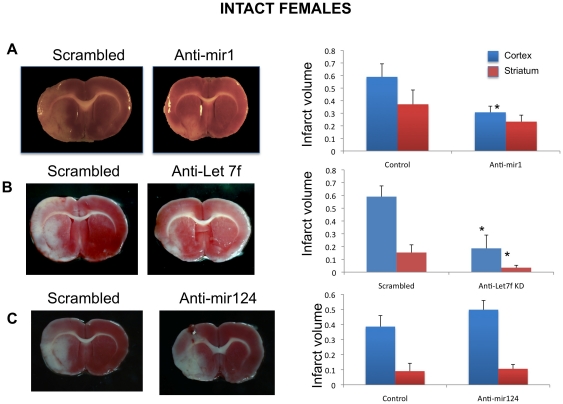
Effect of anti-sense miRNA on infarct volume.Female rats were injected with either anti-sense miRNA or scrambled oligonucleotides (control) 4 h after ET-1 induced middle cerebral artery occlusion (MCAo). Infarct volume was assessed using TTC-stained brain sections and quantitative morphometry. A. Animals injected with anti-miR1 had significantly lower cortical infarct volume as compared to controls injected with a scrambled oligo. Striatal infarct was not significantly different between the two groups. B. Animals injected with anti-Let7f had significantly reduced cortical and striatal infarct volumes as compared to controls. C. Animals injected with anti-miR124 had infarct volumes that were similar to the control group. Histograms depict mean ± SEM. *: p<0.05, n = 5 per group.